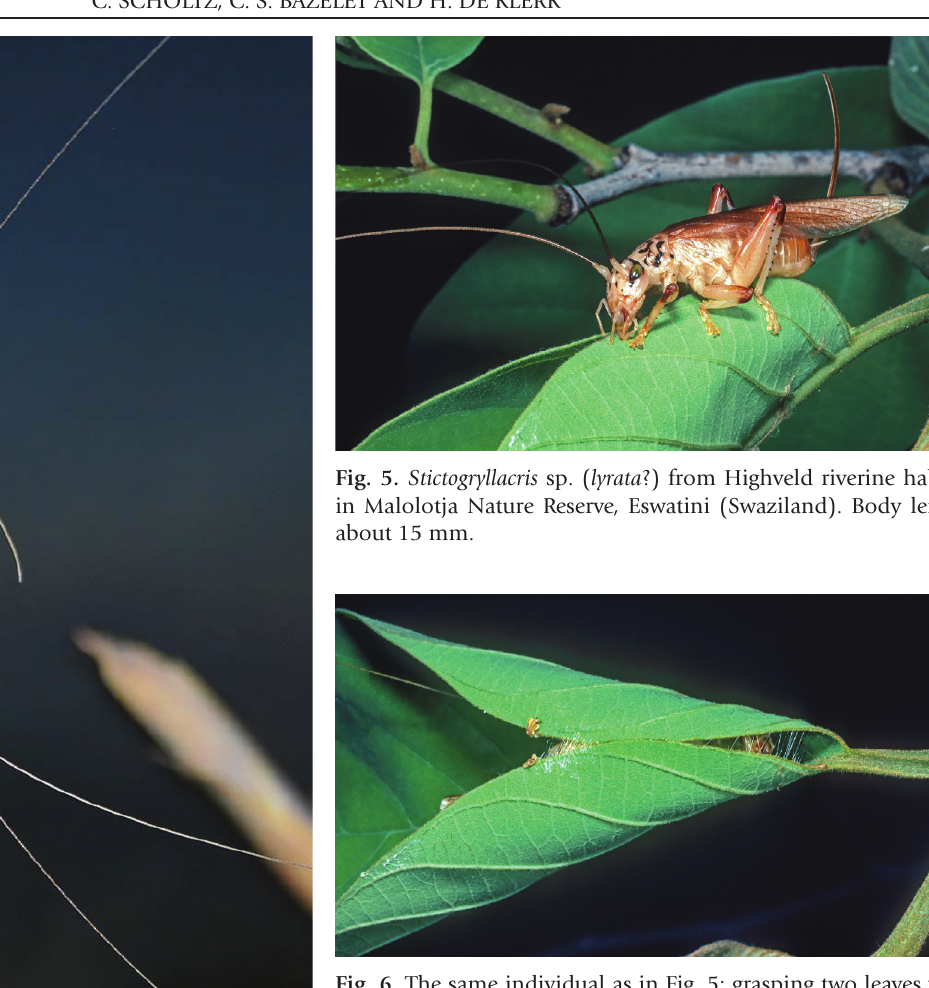
Fig. 6. The same individual as in Fig. 5; grasping two leaves with fore tarsi and pulling them together while attaching them with silk